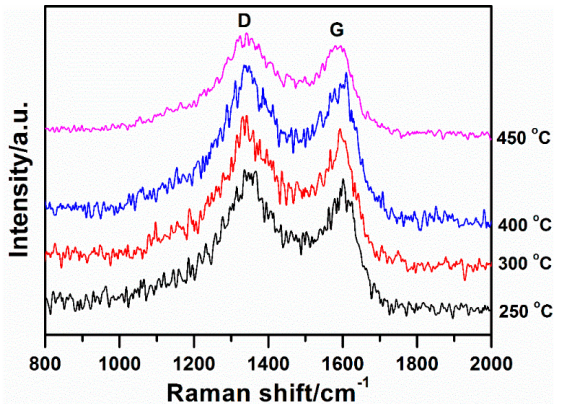
Figure 2. Comparative Raman spectra of CoS/C annealed at temperatures from 250 to 450 °C.